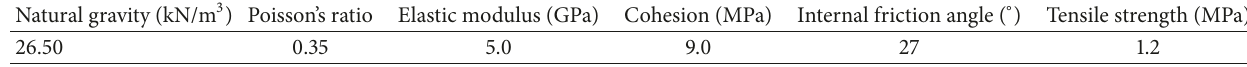
Table 7: Physical and mechanical parameters of the